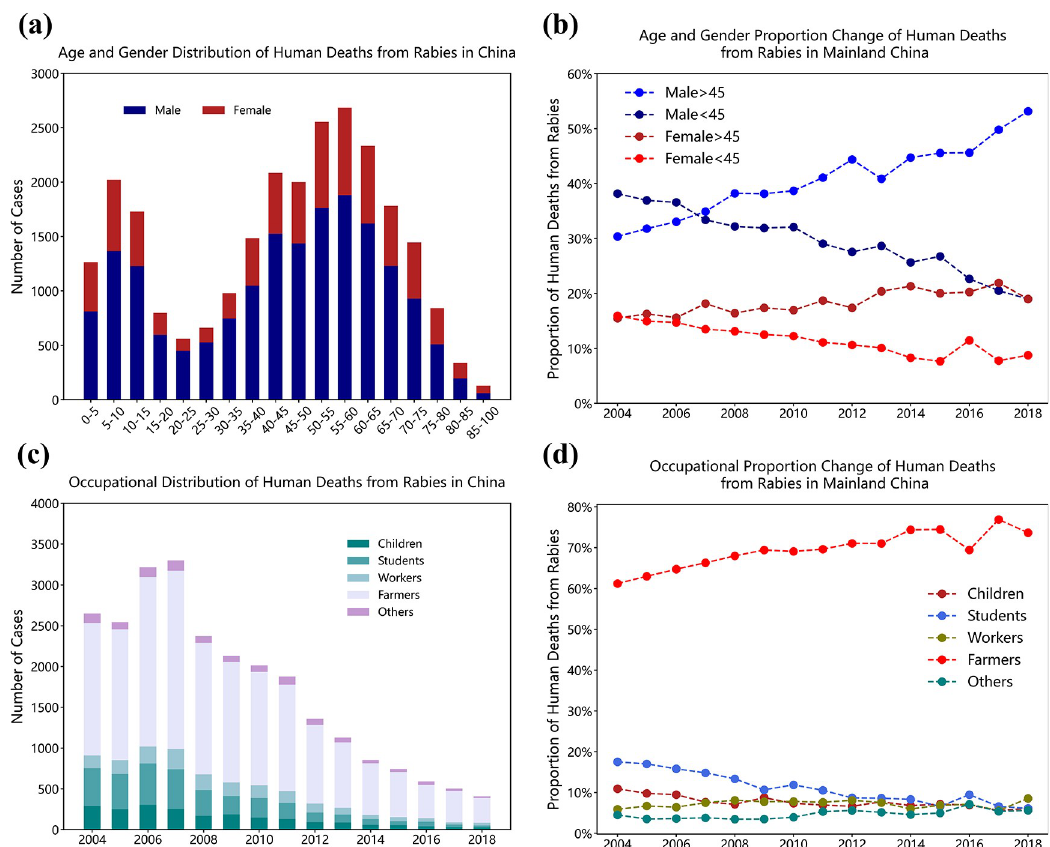
Fig 4. The demographic characteristics of human deaths from rabies in mainland China. (a) Age group and gender distribution of annual human deaths from rabies of from 2004 to 2018 in mainland China. (b) The proportion change of male and female human deaths from rabies above and below 45 years old. (c) Occupational group distribution of annual human deaths from rabies from 2004 to 2018. (d) The proportion change of human deaths from rabies of different occupational groups.